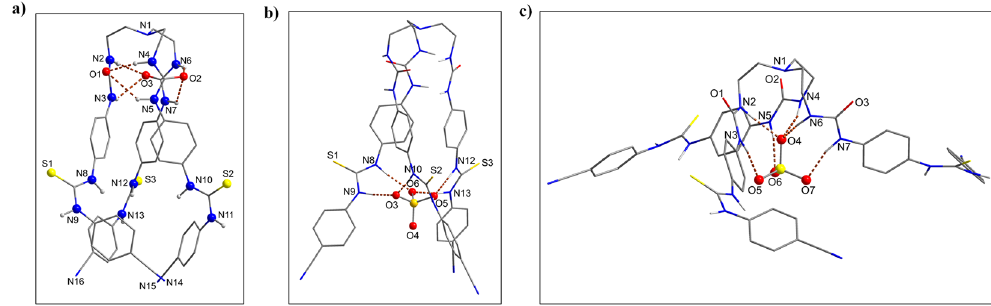
Figure 5. Optimized structures of ( a ) L , ( b ) thiourea-bound 1:1 complex [ L (SO 4 )] 2 − , and ( c ) urea-bound 1:1 complex [ L (SO 4 )] 2 − , calculated at the M06-2X/6-31G(d,p) level of